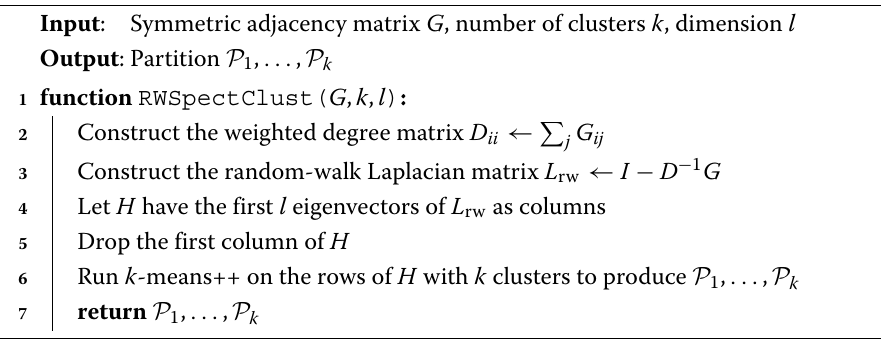
Algorithm 1: Random-walk spectral clustering